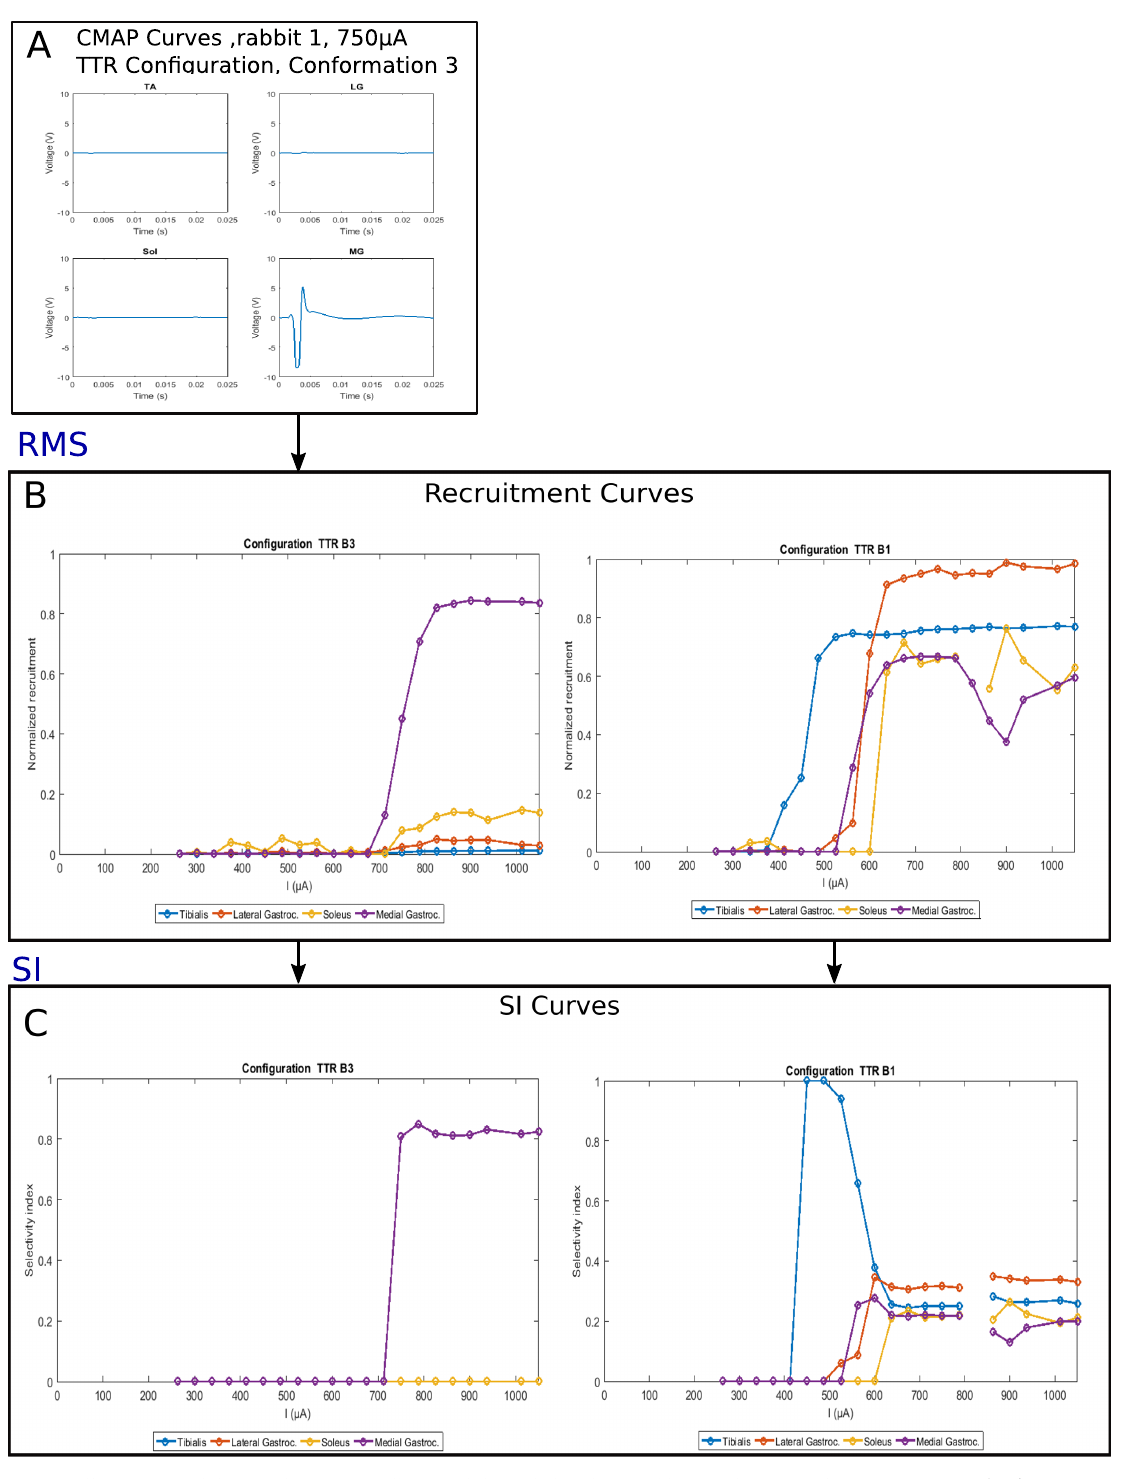
PLOS ONE | https://doi.org/10.1371/journal.pone.0219079 July 2,